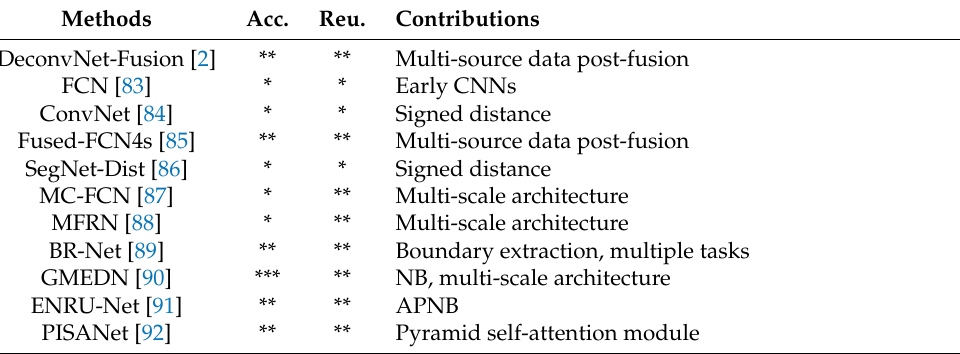
Table 1. Deep learning-based methods on building